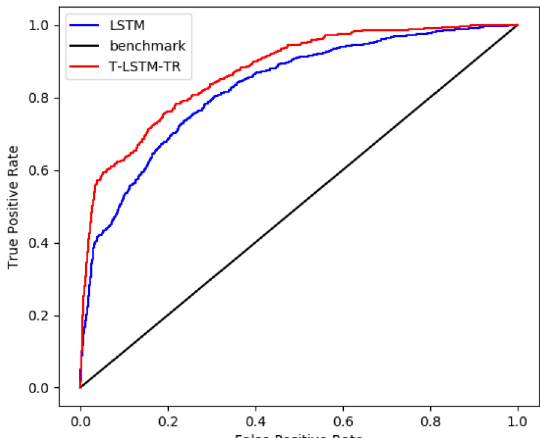
Figure 5. ROC curve of